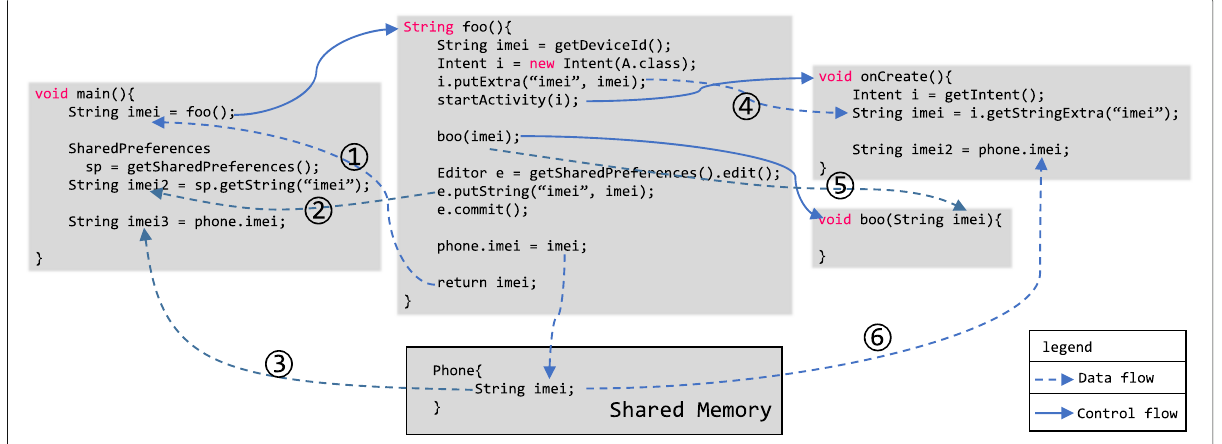
Fig. 4 Taint analysis across multiple